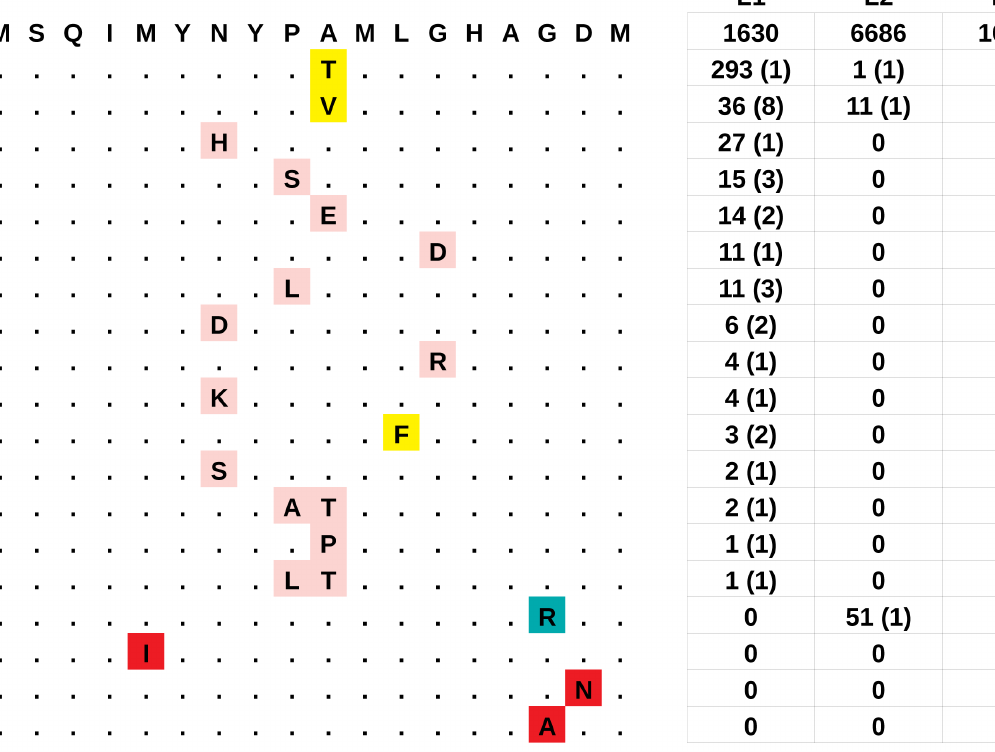
Figure 3. The hypervariable epitope at the N terminus of esxH (aa 1–18). The ancestral epitope is reported in top position, the derived haplotypes are reported below: mutations that were present in more than one lineage are highlighted in yellow, haplotypes that were found exclusively in L1, L2 or L4 are highlighted in pink, blue and red, respectively. Asterisks indicate the position inferred to be under positive selection by PAML: * posterior probability > 0.95: ** posterior probability > 0.99. The table on the right reports for each lineage the number of strains harboring the corresponding haplotype, and between parentheses, the number of independent parallel occurrences of the mutations as inferred by